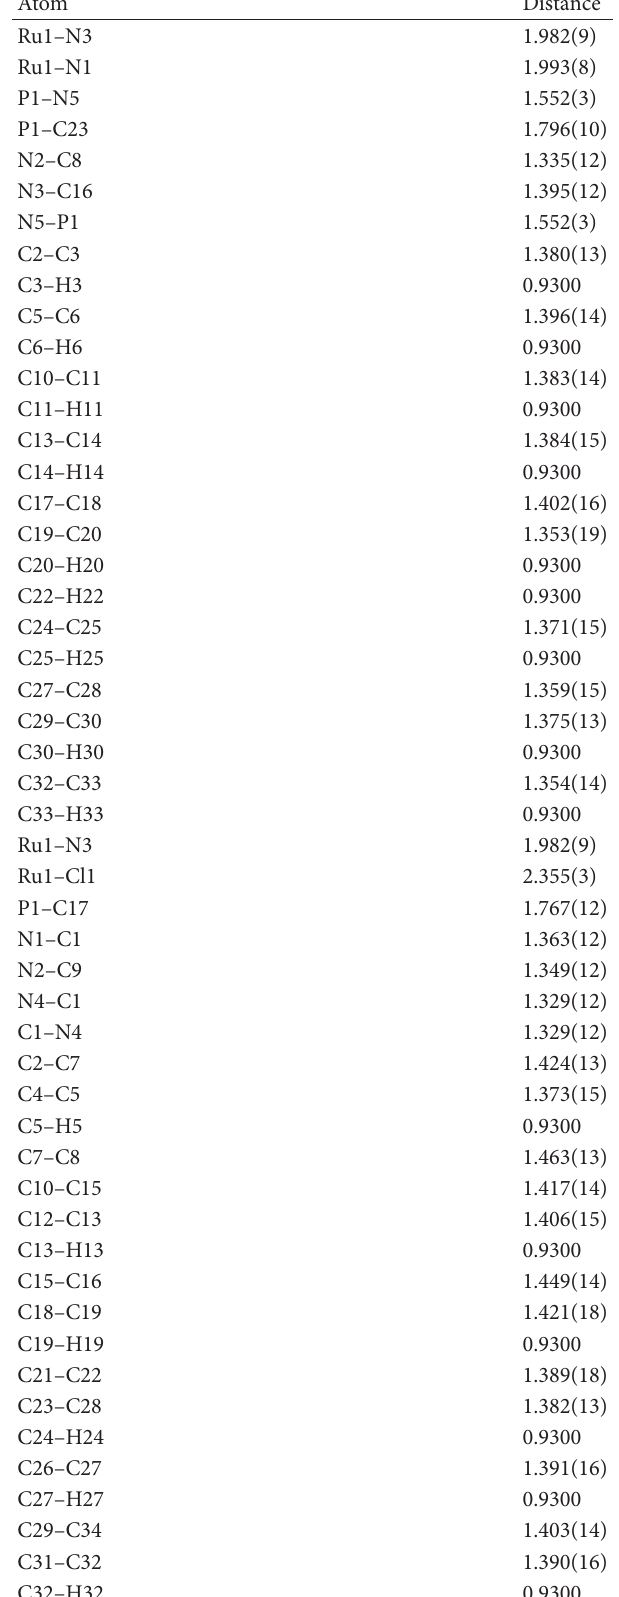
T 1: Crystallographic data collection parameters of ] at PNP[Ru III (Pc)Cl 2